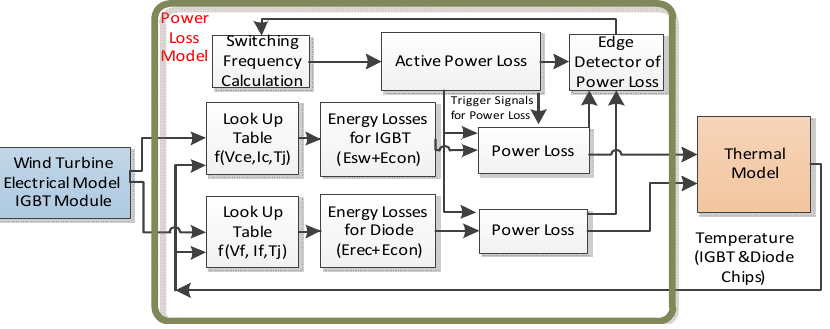
Figure 6. Schematic of the electro thermal model with switching frequency adaption.